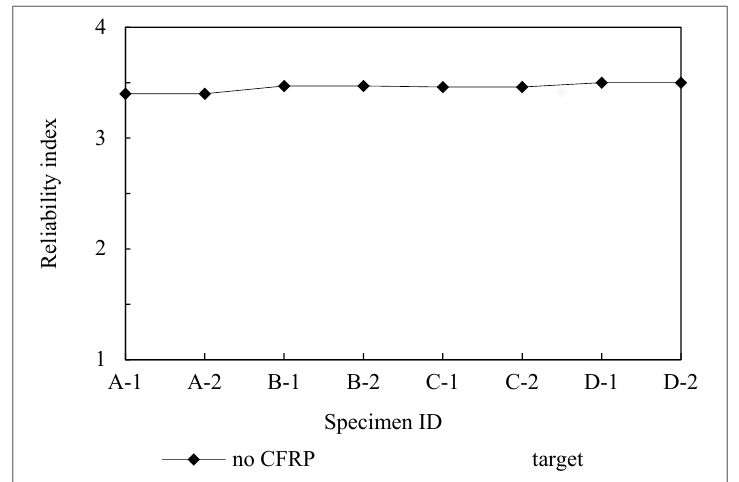
Figure 5. Reliability indices of steel girder without CFRP.